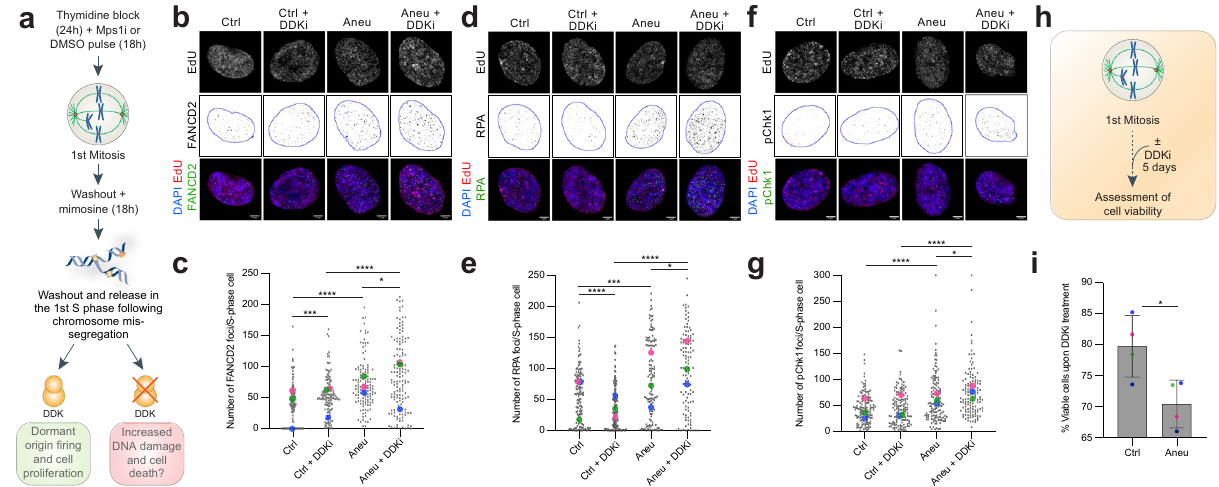
Fig. 2 | DDK protects aneuploid cells from DNA damage accumulation and consequent cell death. a Experimental work fl ow for the analysis of DNA replica- tionstressmarkersinS-phasecellsupontreatmentwiththeDDKinhibitorXL-413.A short EdU pulse was performed before cell harvest in order to label S-phase cells. Representativeimages( b )andquanti fi cation( c )ofFANCD2fociperS-phasecellin control or aneuploid cells ±DDK inhibitor ( n =123 for Ctrl, n =125 for Ctrl+DDKi, n =126 for Aneu, n =137 for Aneu+DDKi). * indicates p =0.0203, *** indicates p =0.0002 and **** indicates p <0.0001. Representative images ( d ) and quanti fi - cation ( e ) of RPA foci per S-phase cell in control or aneuploid cells ±DDK inhibitor ( n =136 for Ctrl, n =134 for Ctrl+DDKi, n =119 for Aneu, n =118 for Aneu+DDKi). * indicates=0.0108, *** indicates p =0.0001 and **** indicates p <0.0001. Repre- sentative images ( f ) and quanti fi cation ( g ) of pChk1 foci per S-phase cell in control or aneuploidcells ±DDKinhibitor ( n =127for Ctrl, n =132 forCtrl+DDKi; n =131for Aneu; n =128 for Aneu+DDKi). * indicates p =0.0449 and **** indicates p <0.0001.